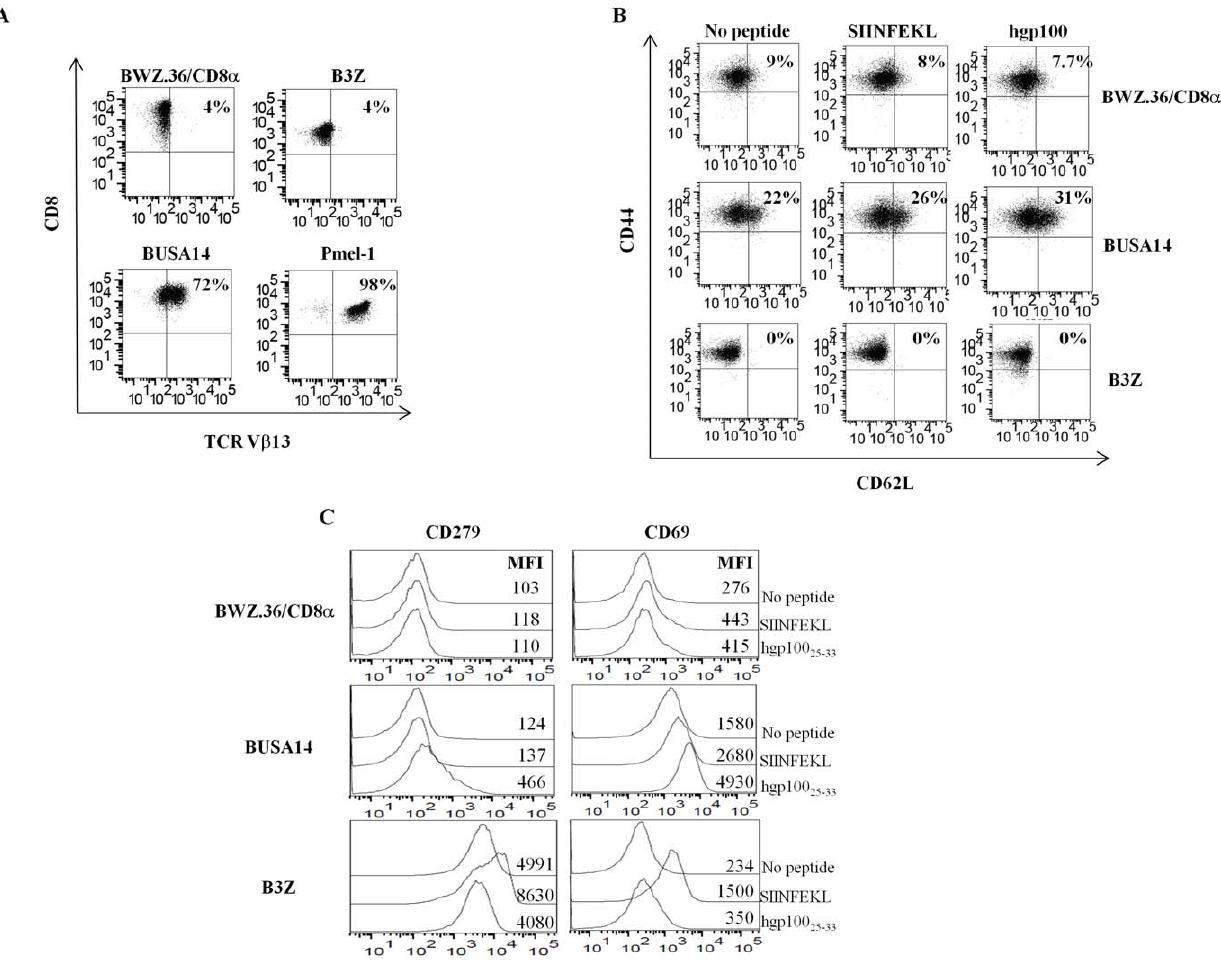
Figure 2. T cell markers expressed by BUSA14 cells. A. BUSA14, B3Z and BWZ.36/CD8 a cells were analyzed by flow cytometry and monoclonal antibodies against CD8 and TCR V b 13 to confirm the Pmel-1 TCR expression. B. BUSA14, BWZ.36/CD8 a and B3Z cells were co-cultured with hgp100 25–33 or SIINFEKL for 12 hours, or remained untreated. Cells were stained with antibodies to CD8, CD62L and CD44 and analyzed by flow cytometry. Cells were gated for CD8 to exclude DC2.4 cells. C. Two million BUSA14, BWZ.36/CD8 a and B3Z cells were co-cultured with 6 6 10 5 DC2.4 loaded with hgp100 25–33 or SIINFEKL for 12 hours, or remained untreated. Then stained with antibodies against CD8, CD69, CD279 and analyzed by flow cytometry. Cells were gated for CD8 to exclude DC2.4 cells. Mean fluorescent intensity (MFI) values are presented in the figure. This figure is a representative of three experimental repeats.